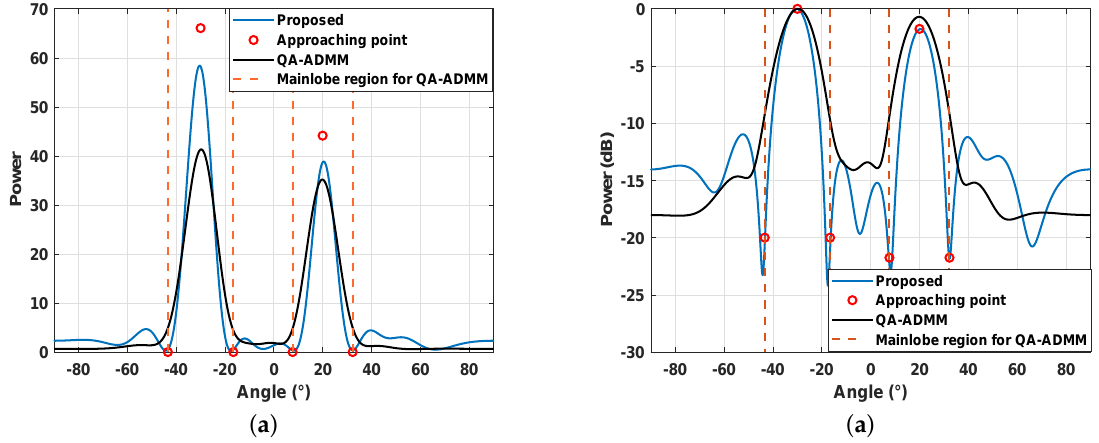
Figure 7. The transmit beampattern. ( a ) The original transmit beampattern. ( b ) The normalized transmit beampattern in dB.